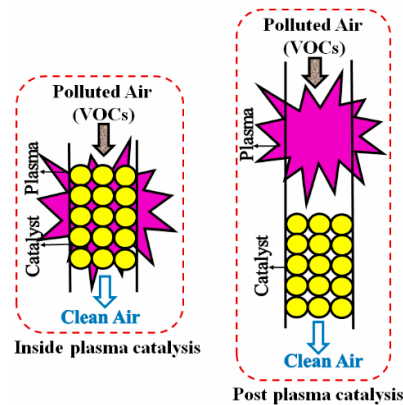
Figure 1. Schematic diagram of continuous plasma-catalysis